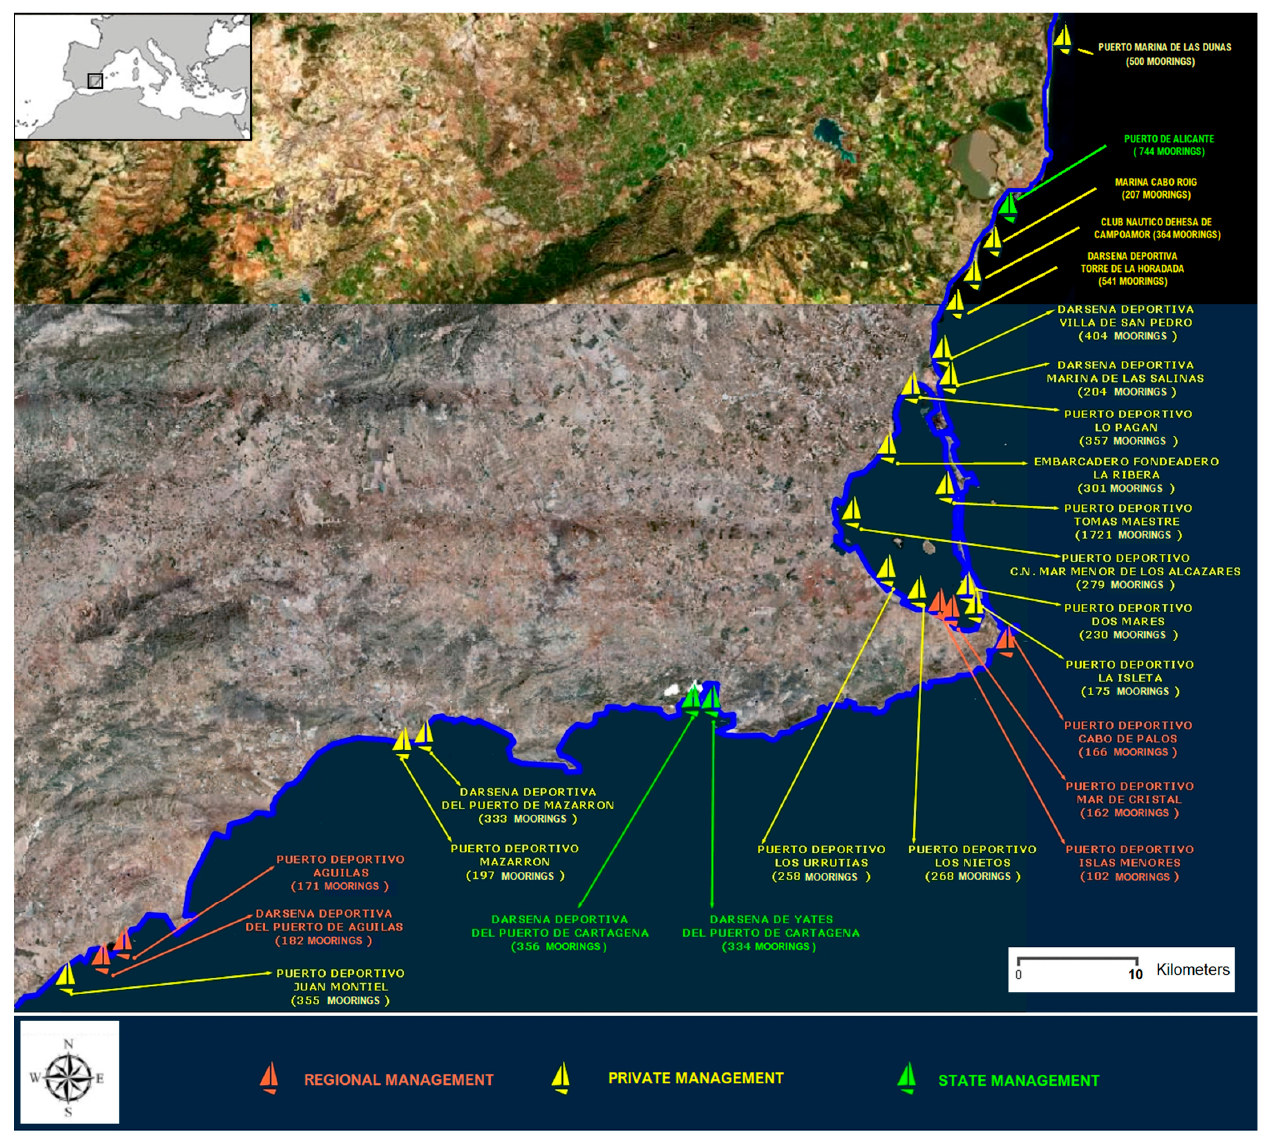
Figure 1. Marinas and urban port areas analyzed in the study